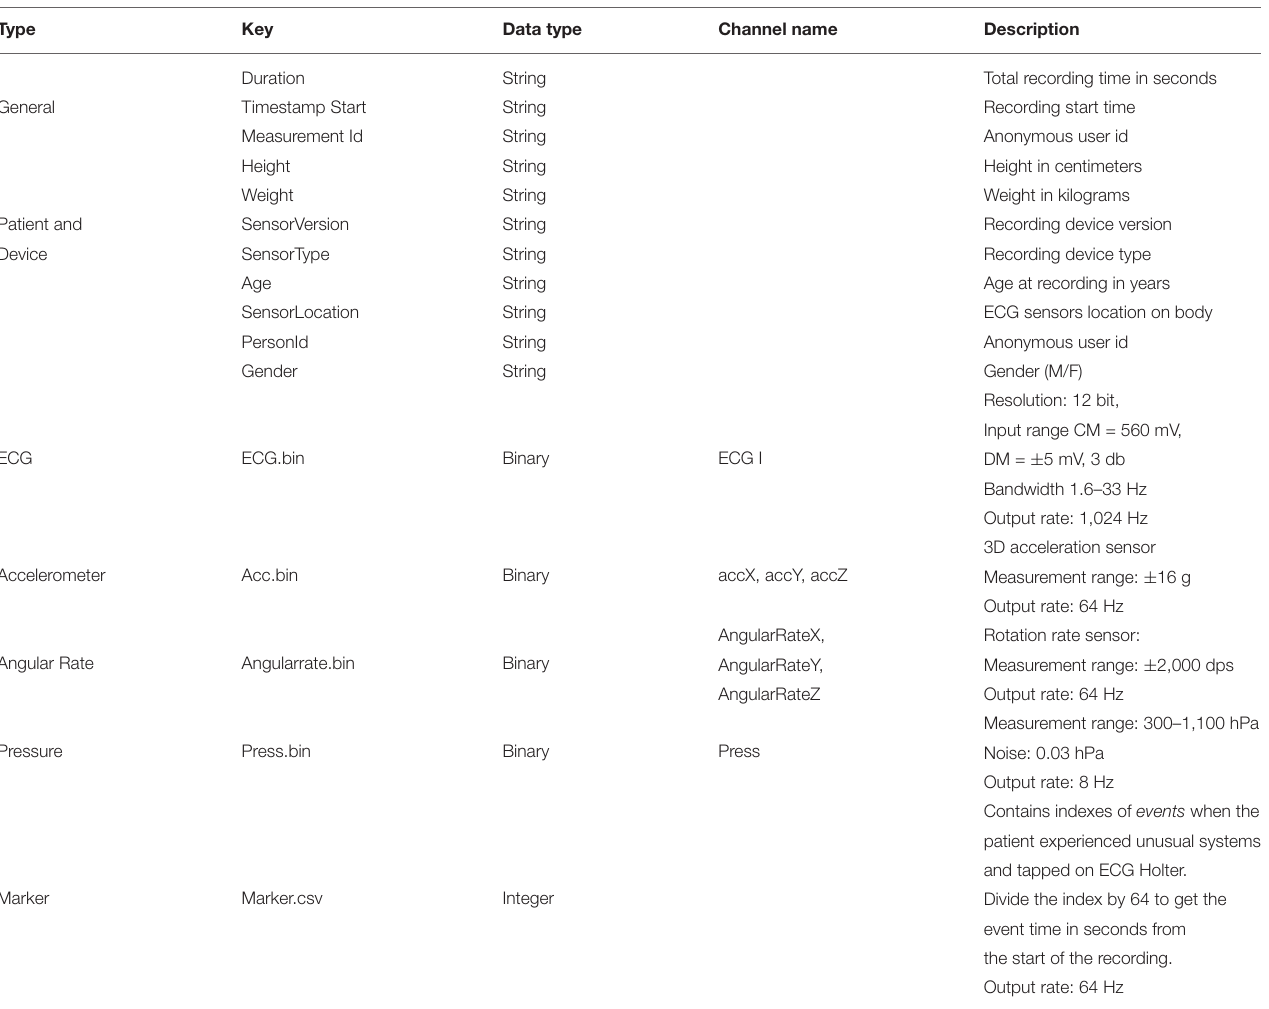
TABLE 3 | Metadata for the signal files described in the unisens.xml file of each